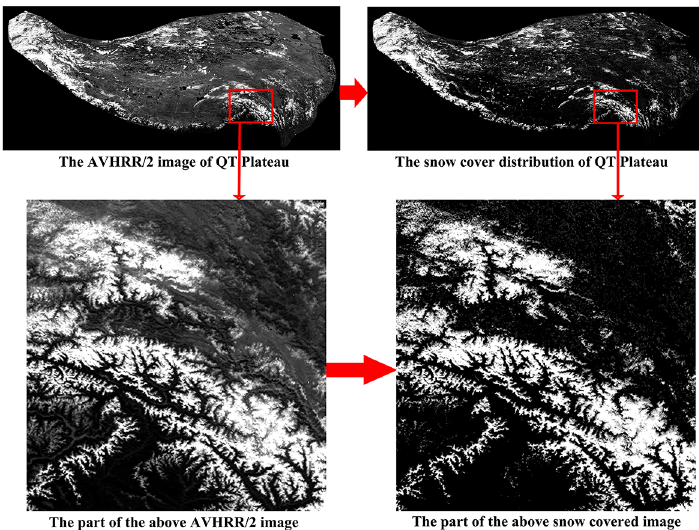
Figure 17. An AVHRR/2 image, and its snow cover distribution from subpixel mapping.